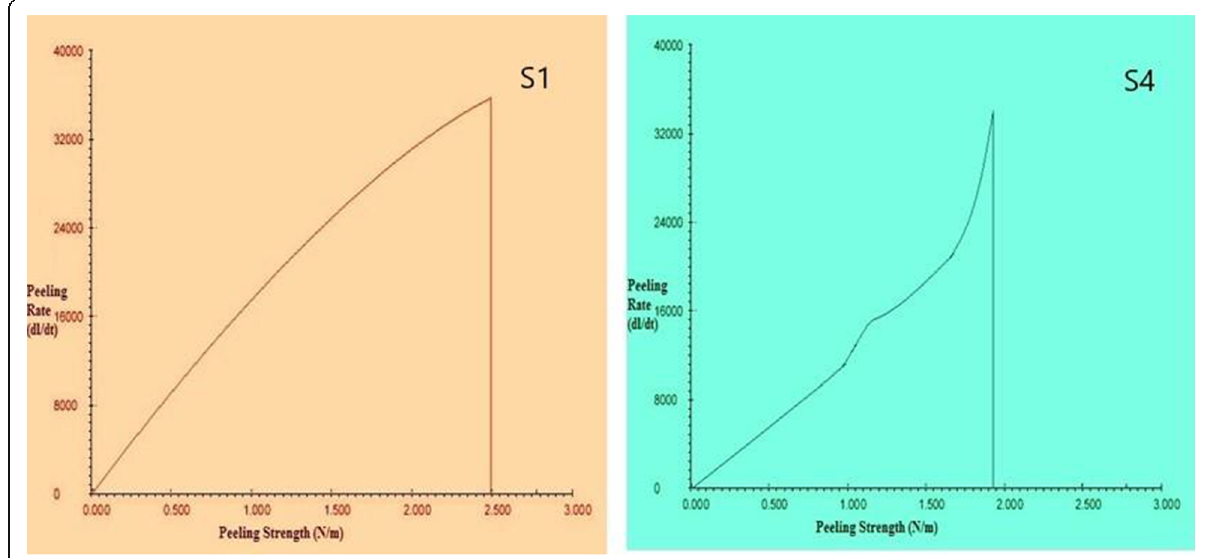
Fig. 2 Peel strength vs peel rate graph of selected formulation S1 and S4